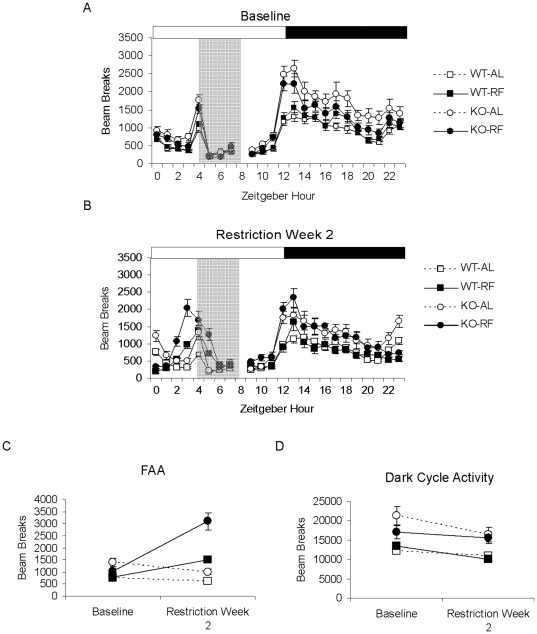
KO mice exhibit enhanced food-anticipatory activity in a standard LD schedule.A. 24-hour activity profile averaged over five days of baseline ad libitum feeding conditions for WT (squares) and KO (circles) mice assigned to either ad libitum (white) or restricted feeding (black) groups. B. 24-hour activity profile averaged over the second week of restricted feeding. C. Locomotor activity during the two hours preceding food availability, averaged over the baseline period and the second week of restricted feeding. D. Locomotor activity during the dark portion of the light/dark cycle, averaged over the baseline period and second week of restricted feeding. All values represent means ±S.E.M.